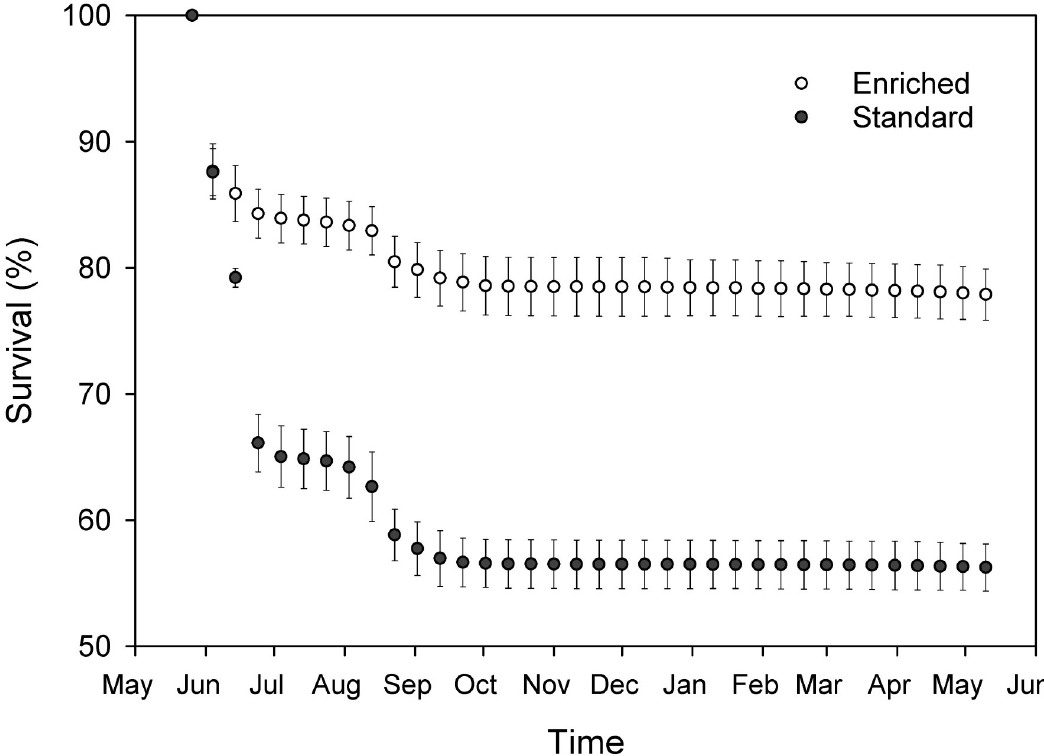
Fig 2. Survival rates of landlocked salmon during the first year (mean ± SD%, n = 4 tanks per rearing method; period: 26 May 2009–11 May 2010) in enriched and standard rearing tanks. For clarity, values are only given for every tenth day. Survival rates of enriched- and standard-reared salmon during the first